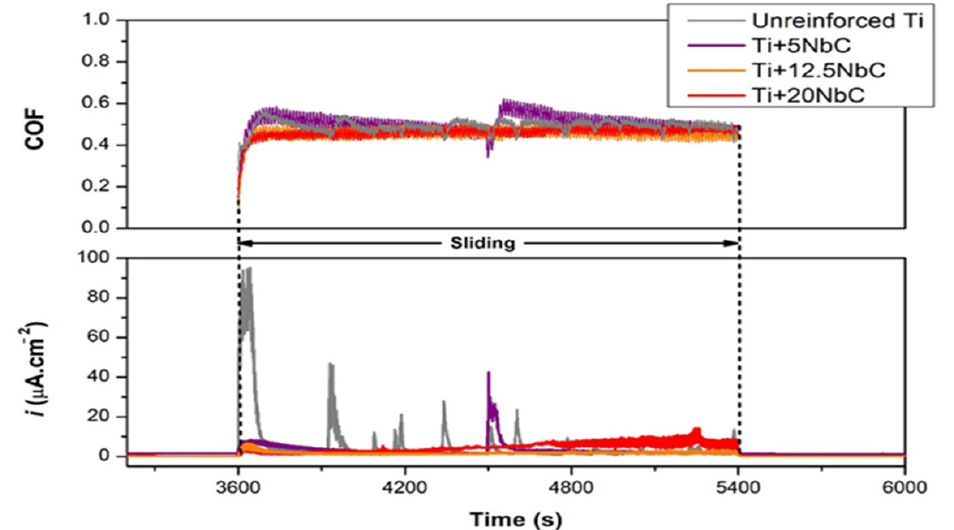
Figure 4. Changes in coefficient of friction and current density during anodic tribocorrosion tests.